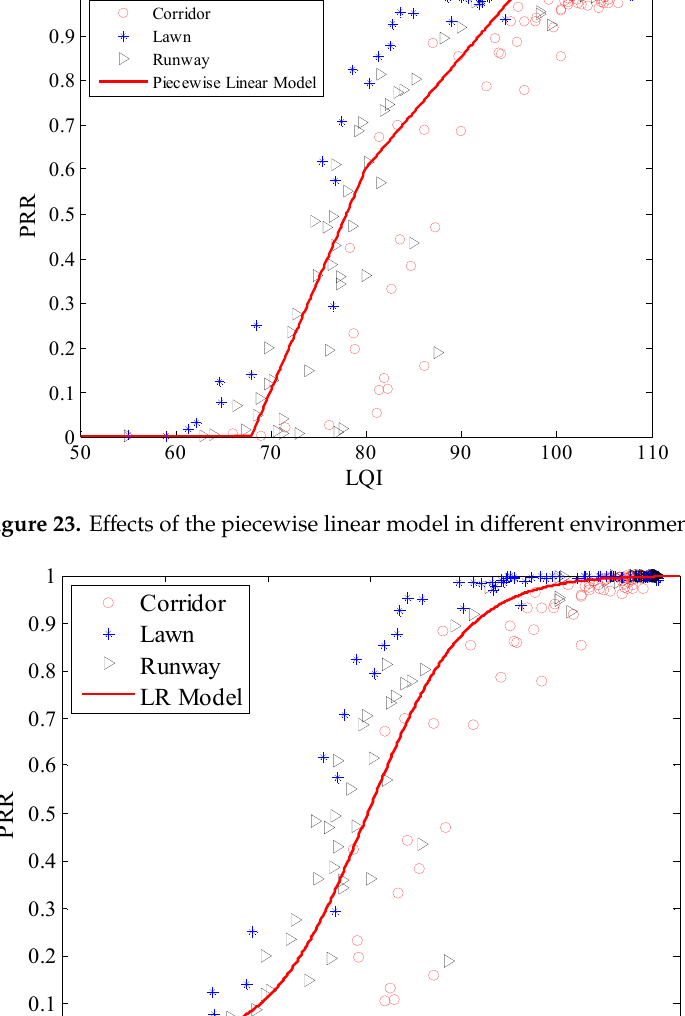
Figure 22. Effects of the cubic model in different environments.